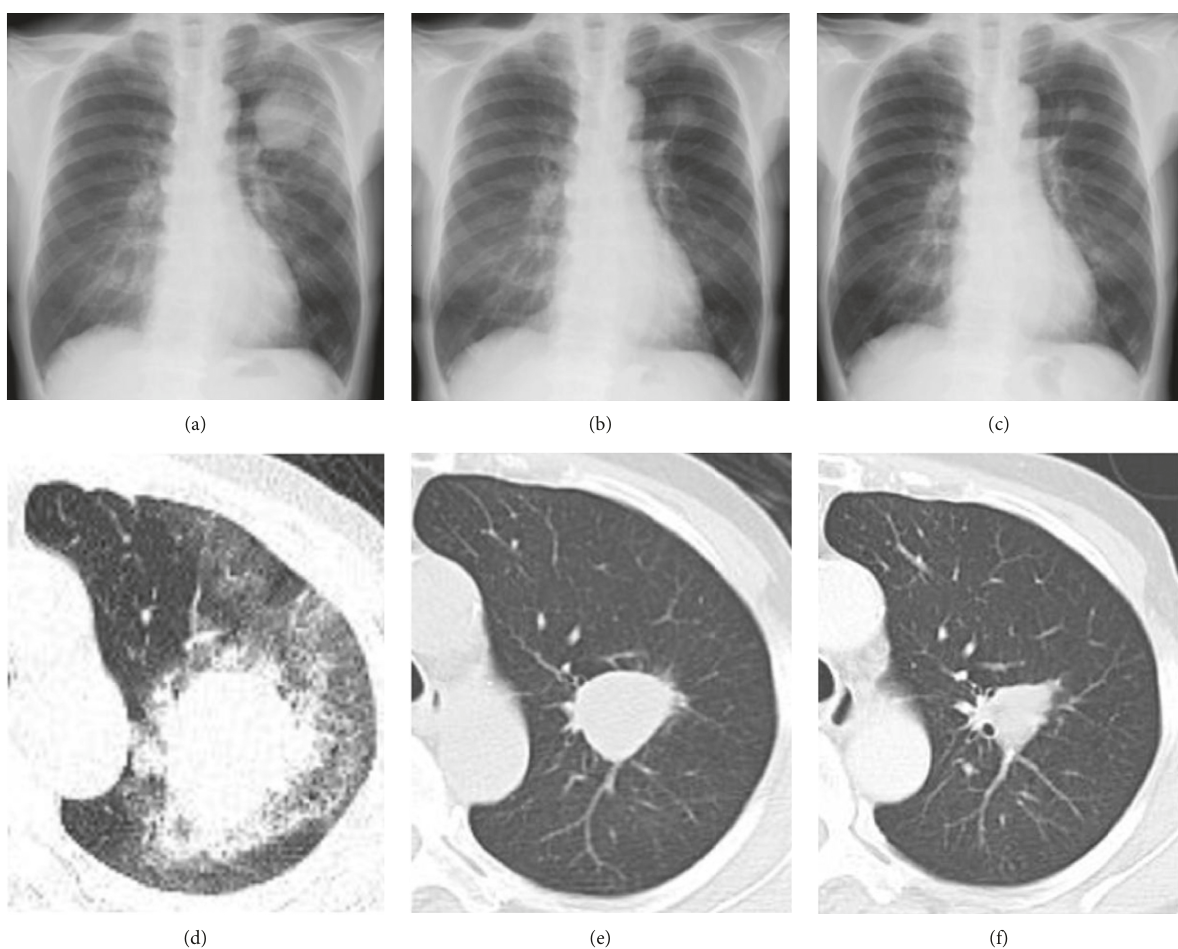
Figure 3: Diameters of the primary tumor before starting treatment with pembrolizumab (a and d), and after two (b and e) and four (c and f) cycles of